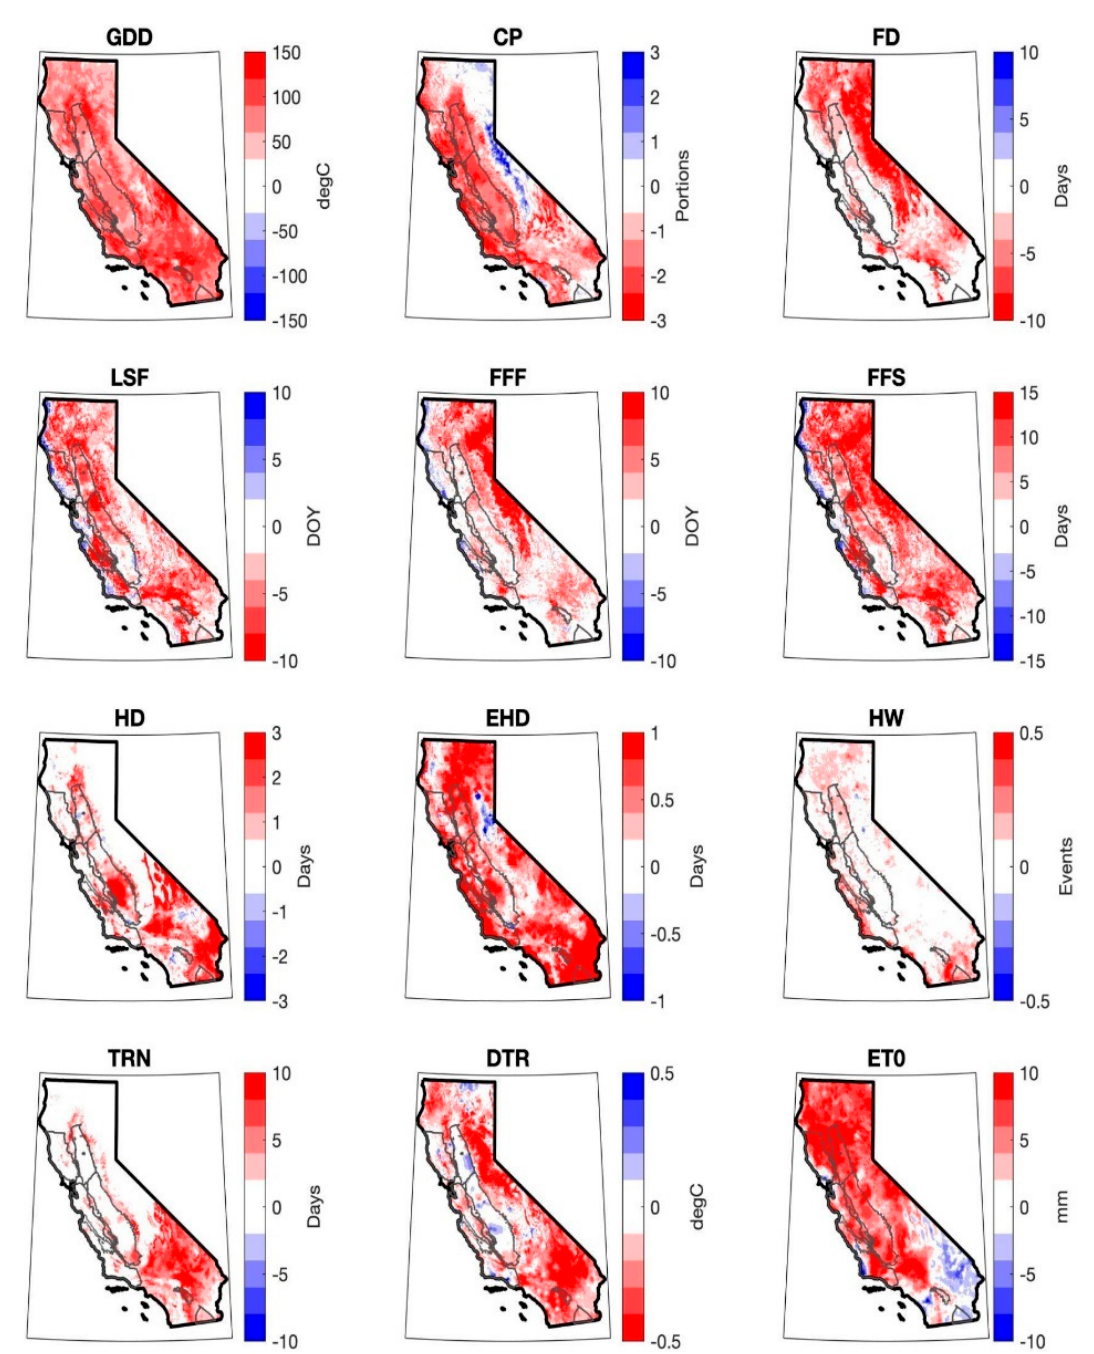
Figure 2. Changes in 12 agroclimate metrics between the previous (1981–2010) and current (1991–2020) normal periods. Agricultural regions are outlined in grey. Metrics are shown as: row 1: growing degree days (GDD), chill portions (CP), frost days (FD); row 2: last spring freeze (LSF), first fall freeze (FFF), frost-free season (FFS); row 3: heat days (HD), extreme heat days (EHD), heatwaves (HW); row 4: tropical nights (TRN), diurnal temperature range (DTR), summer reference evapotranspiration (ETo).